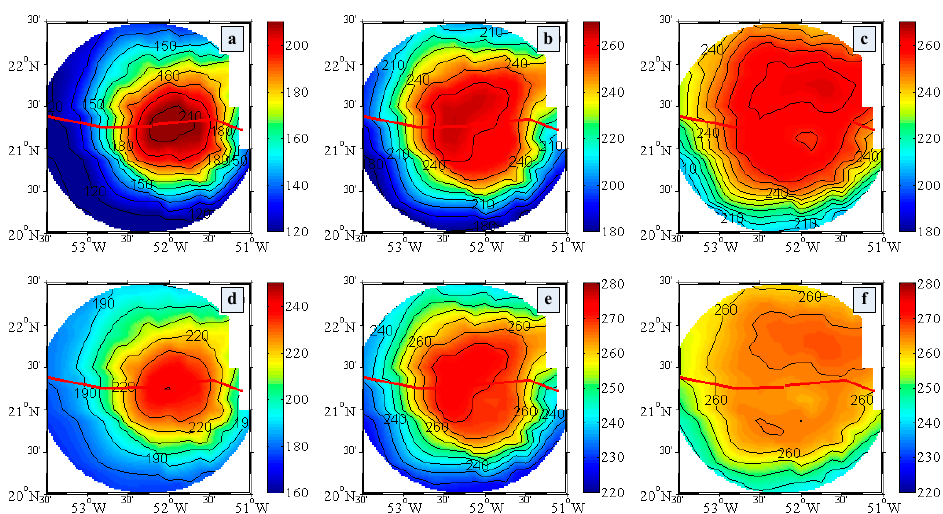
Figure 3. Brightness temperatures measured by WindSat orbit #3510 on 10 September 2003, over hurricane Isabel ( a ) at 10.7 GHz, horizontal polarization; ( b ) at 18.7 GHz, horizontal polarization; ( c ) at 37.0 GHz, horizontal polarization; ( d ) at 10.7 GHz, vertical polarization; ( e ) at 18.7 GHz, vertical polarization and ( f ) at 37.0 GHz, vertical polarization. The red curve denotes the best track, which was obtained from the NHC.